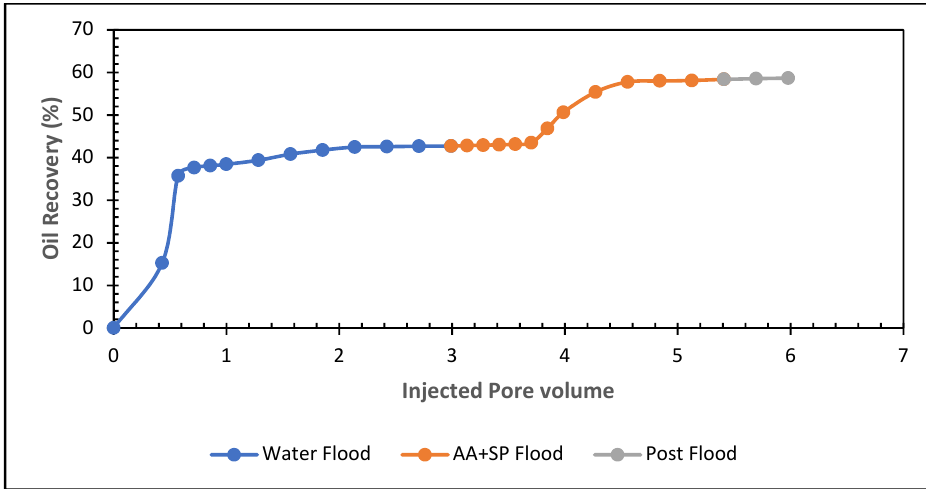
Figure 20. Total oil production from the carbonate core after brine, 0.5% acetic acid, and SP mixture, followed by a post-flood with brine.